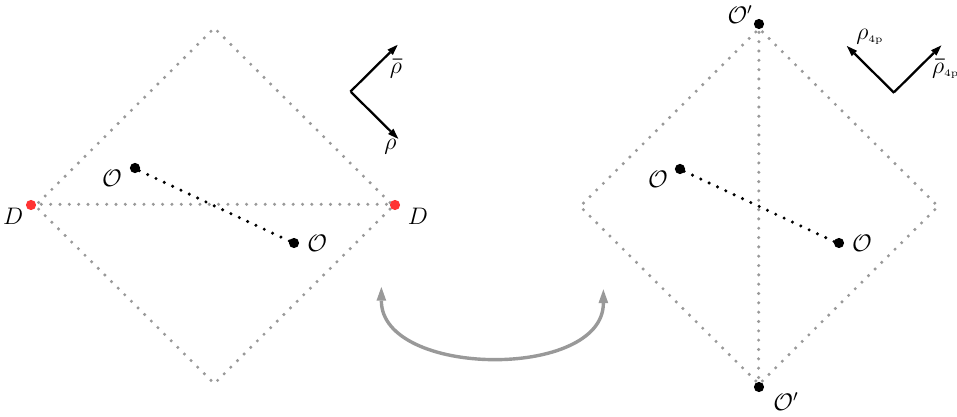
Figure 10 . The geometric equivalence of a codimension two defect to a pair of local operators. In Minkowsky space, ( (cid:26); (cid:22) (cid:26) ) are independent real coordinates. The locus of the defect on the left | in red | is the intersection of the light-cones of the two time-like separated points at the top and bottom of the diamond on the